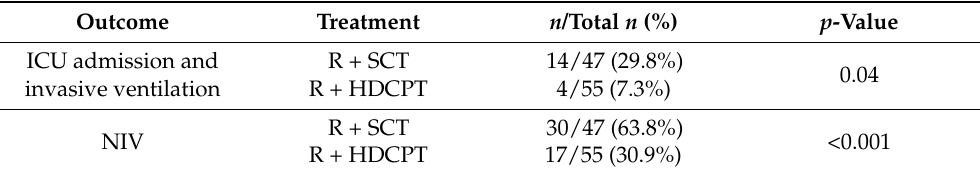
Table 2. Need for admission to the ICU with invasive ventilation and NIV in the Remdesivir + HDMPT and Remdesivir + SCT groups.